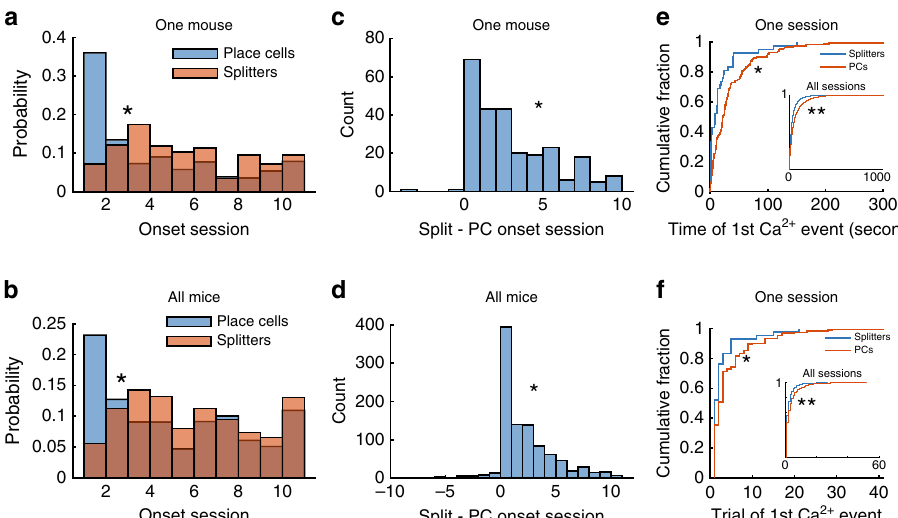
Fig. 7 Place cell recruitment peaks prior to splitter onset between but not within sessions. a Histogram of the fi rst (onset) day a neuron is identi fi ed as a splitter cell or place cell for one mouse. * p = 8.2 × 10 − 19 , one-sided Kolmogorov – Smirnov test, n = 1628 place cells and 263 splitters. b Same as ( a ) but for all mice. * p = 2.0 × 10 − 21 , one-sided Kolmogorov – Smirnov test, n = 5062 place cells and 612 splitters. c Difference between splitter cell onset day and place cell onset day for one mouse. * p = 8.2 × 10 − 18 χ 2 goodness-of- fi t test, mean = 2.54, median = 2, n = 256 neurons. d Same as ( c ) but for all mice. * p = 5.5 × 10 − 79 χ 2 goodness-of- fi t test, mean = 1.7, median = 1, n = 982 neurons. e Cumulative probability plot of splitter vs. place cell recruitment time for one mouse. (inset) all mice/sessions. * p = 3.5 × 10 − 4 ( n = 42 splitters and 192 place cells), ** p = 3.9 × 10 − 50 ( n = 1190 splitters and 11232 place cells), one-sided Kolmogorov – Smirnov test. f Cumulative probability plot of splitter vs. place cell recruitment trial for same session shown in ( e ) (inset) all mice/ sessions. * p = 0.01 ( n = 42 splitters and 192 place cells), ** p = 1.2 × 10 − 24 ( n = 1190 splitters and 11232 place cells), one-sided Kolmogorov – Smirnov